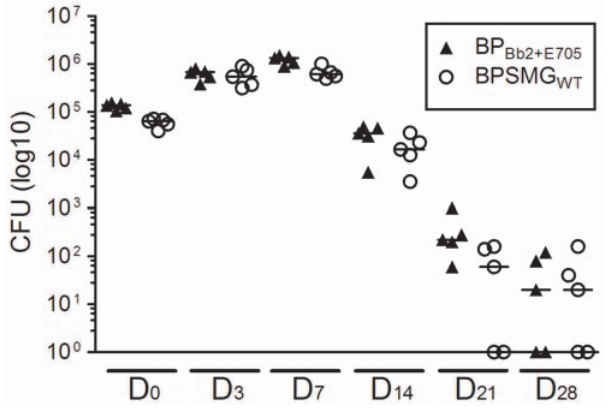
Figure 6. Colonization of mice lungs by two strains in a mixed infection. Balb/c mice were infected intranasally by 1.6 6 10 5 CFU of each BPSMG WT and BP Bb2 + E705 . At the indicated time points, mice were killed, and the viable bacteria present in the lungs were counted. 5 mice were analyzed per time point. The two bacterial strains were distinguished by an antibiotic marker. Medians for each group are shown.